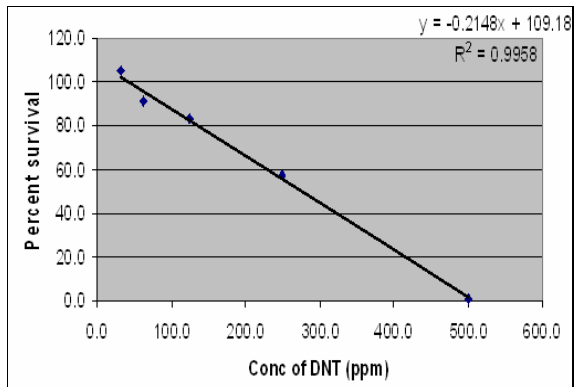
Figure 1: Regression analysis for breast cells exposed to different concentrations of 2,4 DNT.